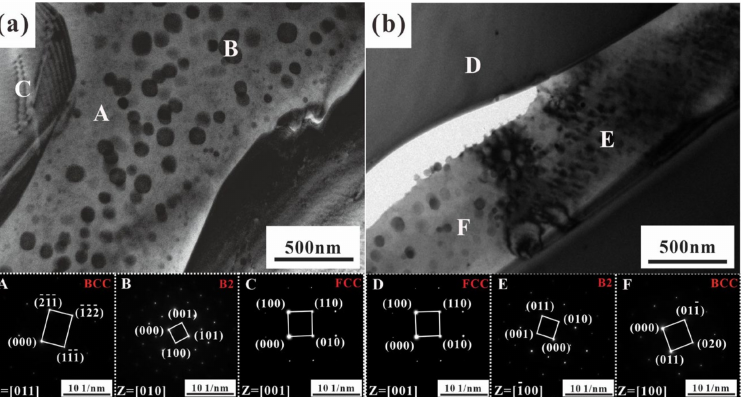
Figure 3. TEM images and electron diffraction patterns of Al 0.6 CrFe 2 Ni 2 HEAs in as-cast and cryogenically treated states: ( a ) as-cast; ( b ) cryogenic treatment for 48 h. The electron diffraction patterns correspond to the regions in the TEM images. Region A and F correspond to the inter- dendritic BCC structure; region B and E correspond to the spherical B2 nanophases embedded in the inter-dendritic structure; region C and D correspond to the FCC crystal